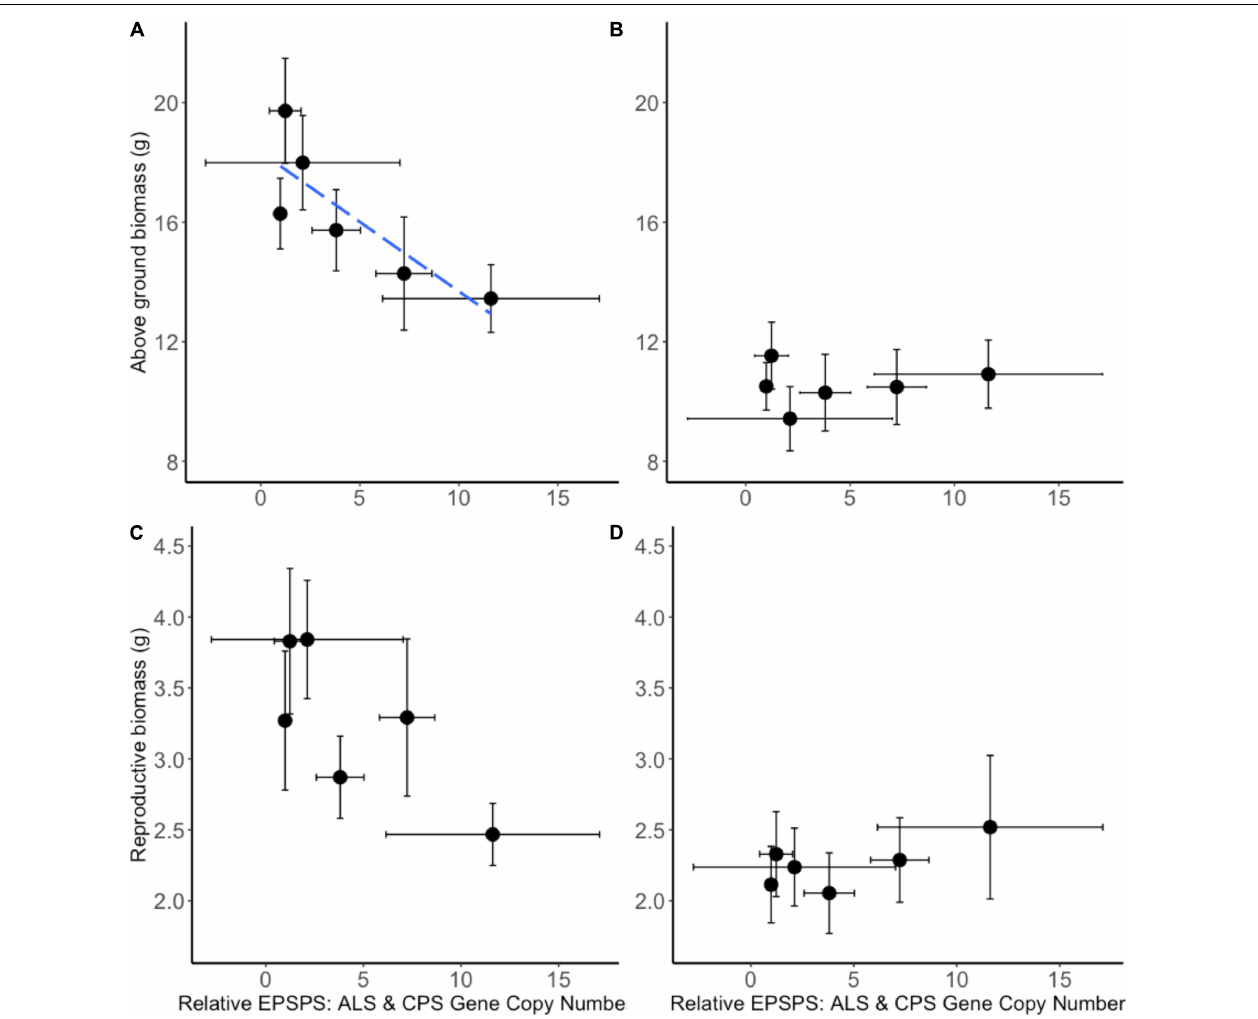
FIGURE 6 | Biomass of common waterhemp seed families grown in neighborhood design experiment. The relationship between Amaranthus tuberculatus seed family average above ground biomass (A,B) and reproductive biomass (C,D) compared to the average 5-enolpyruvylshikimate-3-phosphate synthase ( EPSPS ) gene copy number relative to carbamoyl phosphate synthetase ( CPS ) and acetolactate synthase ( ALS ) reference genes. Panels (A,C) represent A. tuberculatus plant measures when grown under intra-phenotypic competition. Panels (B,D) represent A. tuberculatus measures when plants are grown in interspecific competition with maize. Ten replicate pots containing four replicate common waterhemp plants were assessed for each seed family and each treatment and 6–8 replicate plants from each seed family were assessed for EPSPS gene copy number. The blue dashed line represents a significant linear relationship between variates. A correlation of r = –0.83, p < 0.05 was found between relative EPSPS gene copy number and above ground biomass (A) . A non-significant relationship r = –0.76, p = 0.08 was between relative EPSPS Gene Copy Number and reproductive biomass (C) . No significant relationship was found in the presence of maize (B,D) . Error bars are standard errors of the